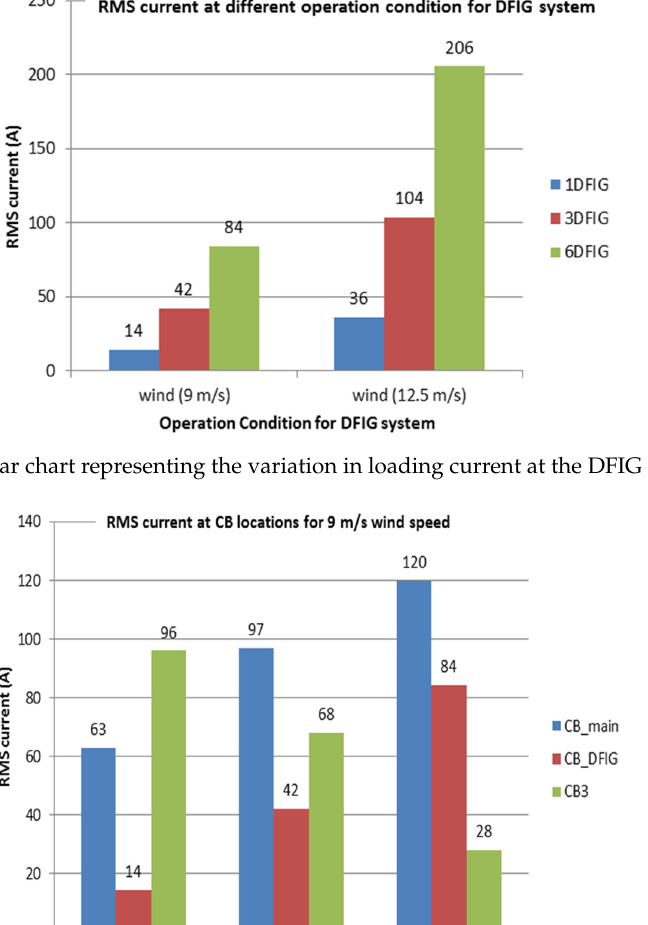
Figure 3. The effect of wind speed on the loading current of the DFIG system. Figure 3. The e ff ect of wind speed on the loading current of the DFIG